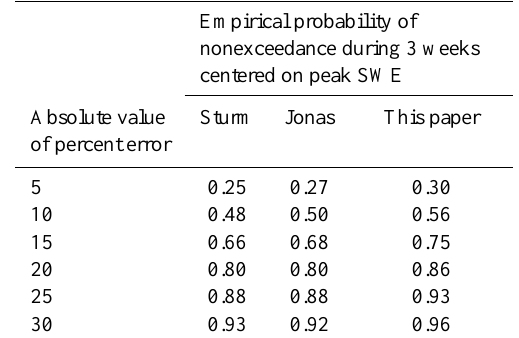
Table 2. Nonexceedance probabilities for a range (of absolute value) of percent error calculated for three-week windows centered on peak SWE. Numbers apply to both density and SWE as depth is observed and assumed to be correct. Jonas et al. (2009) cite typical values of density measurement error as